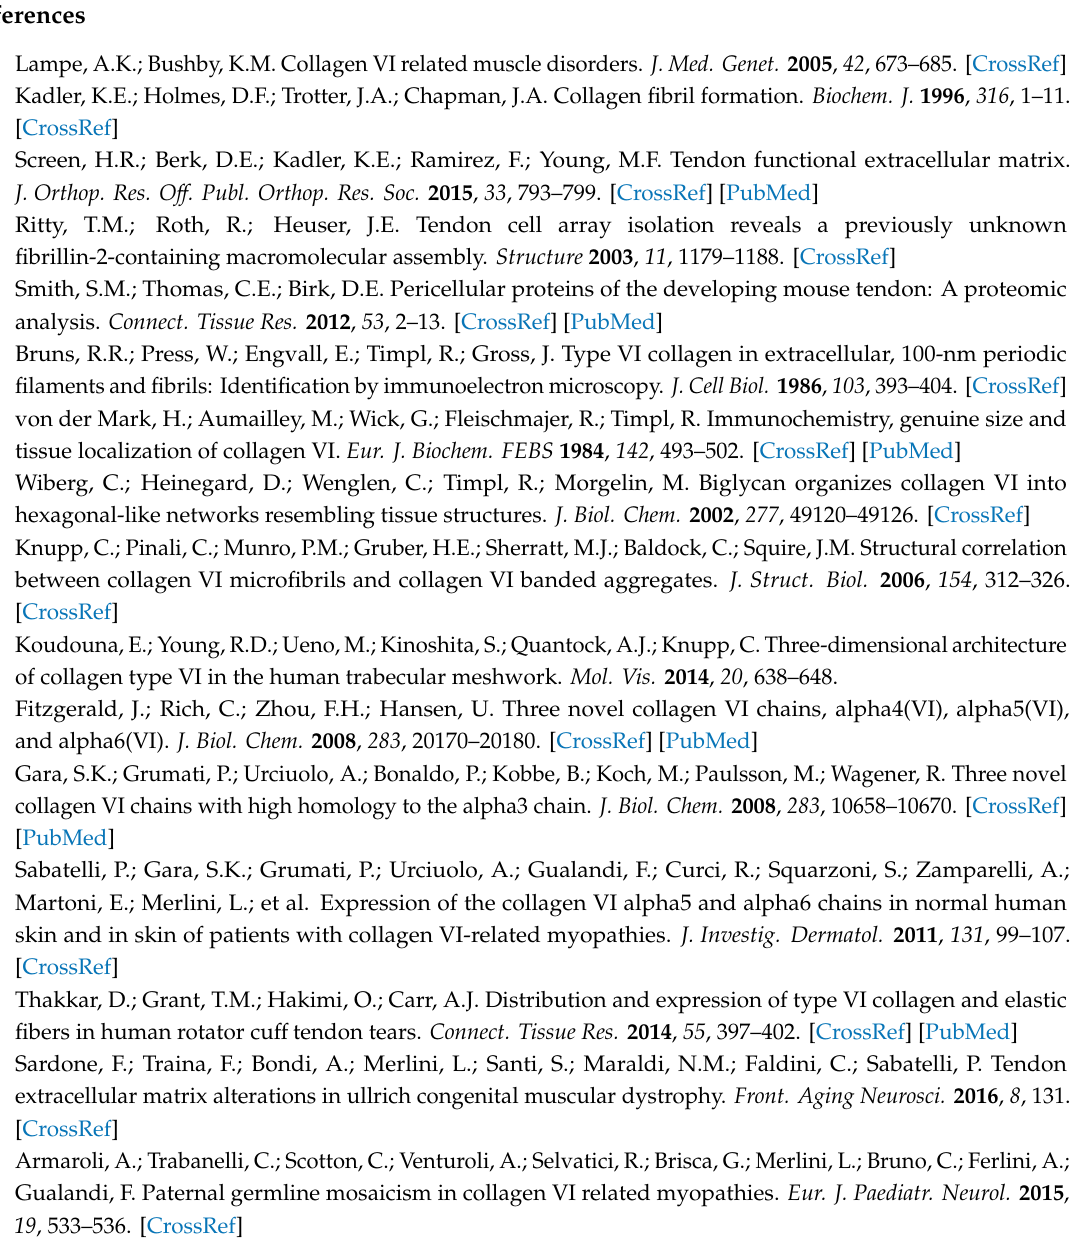
Figure S1: Biochemical, colocalization and ultrastructural analysis of patients’ cultures and